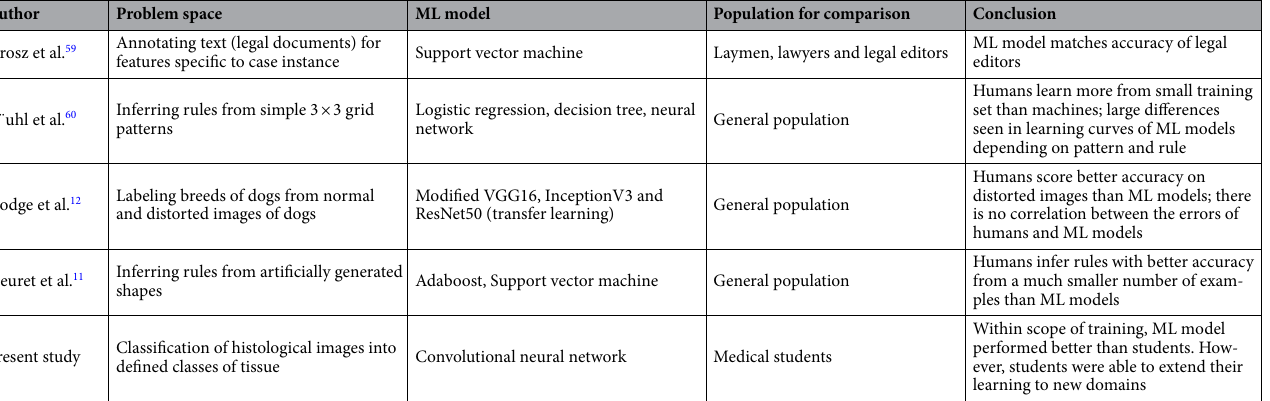
Table 13. Summary of recent studies comparing human and machine learning, along with the approach taken in the present